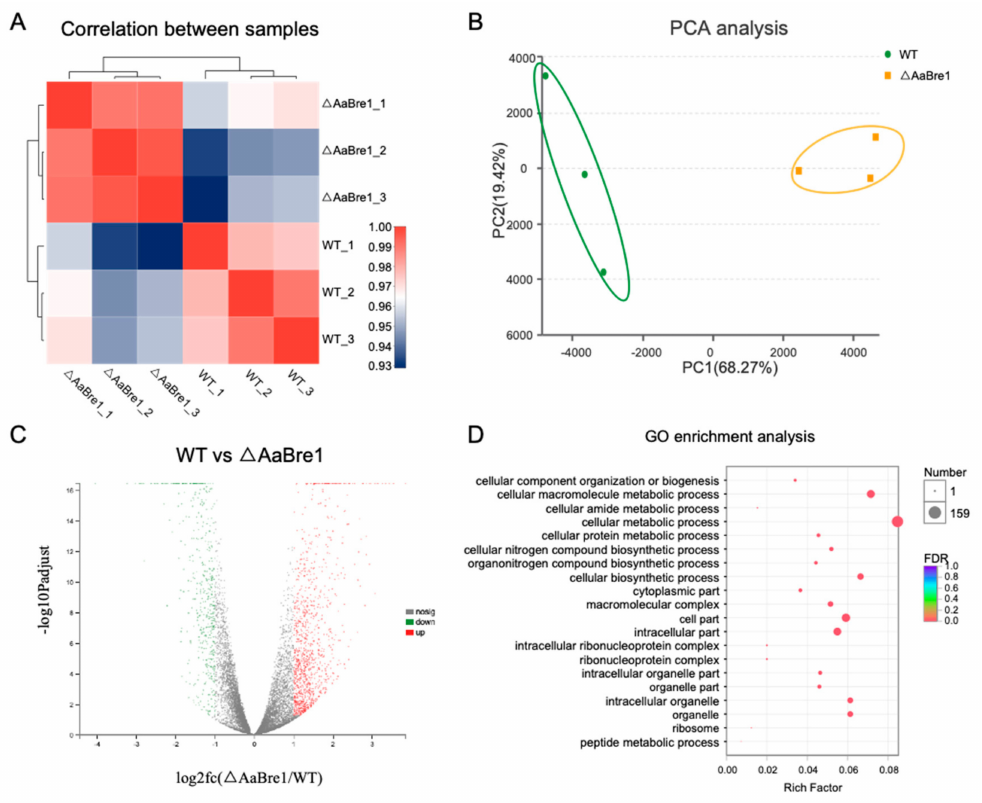
Figure 7. RNA sequencing analysis of the transcriptomes between WT and ∆ AaBre1 strains. ( A ) Correlation analysis between samples. ( B ) PCA analysis between samples. ( C ) Volcano